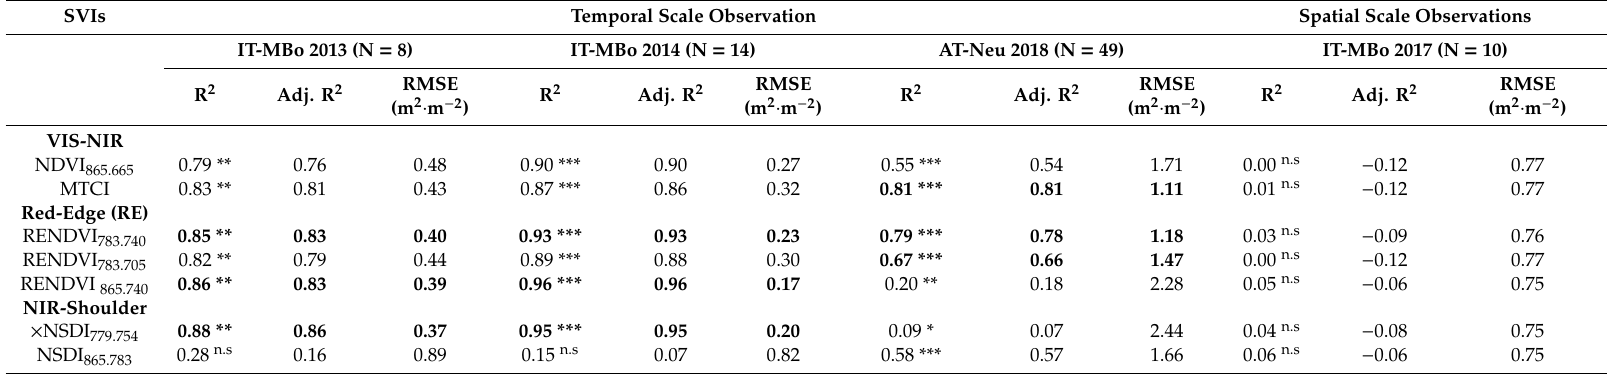
Table 5. Summary of the statistics (N, Number of observations; R 2 , coe ffi cient of determination; Adj. R 2 , adjusted coe ffi cient of determination; RMSE, root mean square error) of the linear regression between leaf area index (LAI, m 2 · m − 2 ) estimated from fraction of absorbed photosynthetically active radiation (fAPAR) and